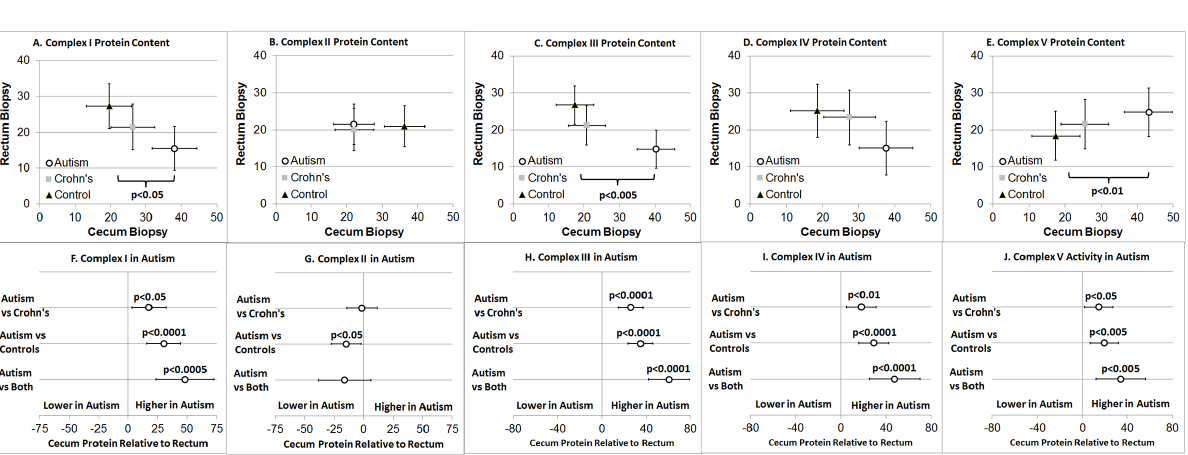
Fig 4. Electron transport chain normalized complex protein quantity. Cecum protein quantity is greater in the autism group as compared to the two control groups for (A) Complex I, (C) Complex III and (E) ComplexV. In the cecum, relativeto the rectum, protein content is greater in the autism group as comparedto the control groups both separately and combinedfor (F) Complex I, (H) Complex III, (I) Complex IV and (J) ComplexV. Error bars represent standard error. The protein quantity values do not have any units becausethey are normalized.ASD = Autism Spectrum